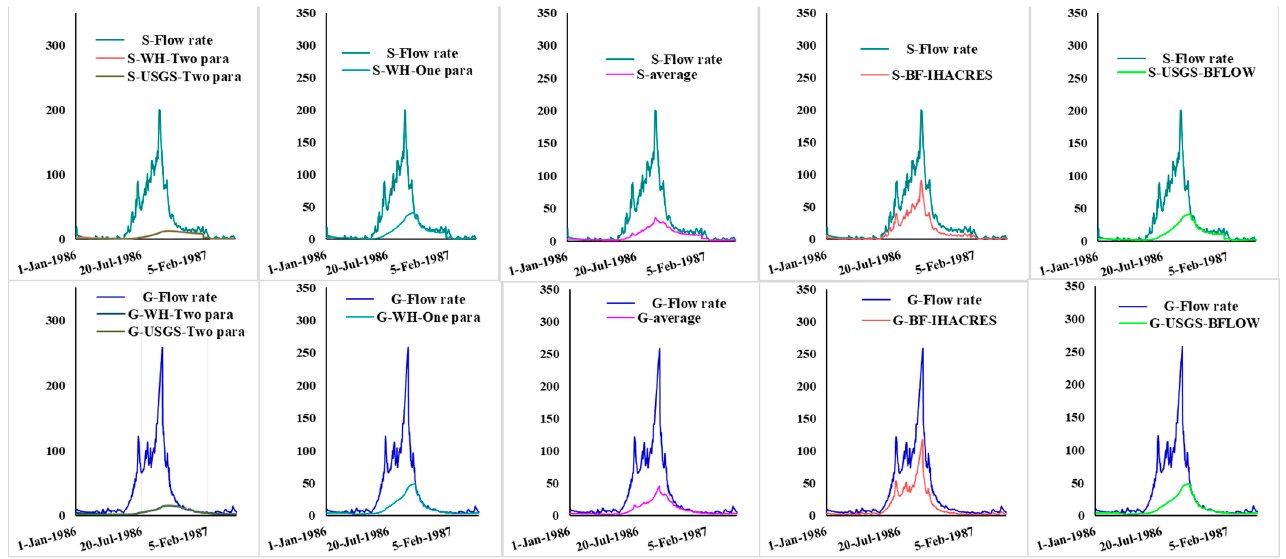
Figure 19. Baseflow separation using all candidate methods for both streams. (Results of all candidate methods are dis- played together. This figure shows a one-year baseflow separation).